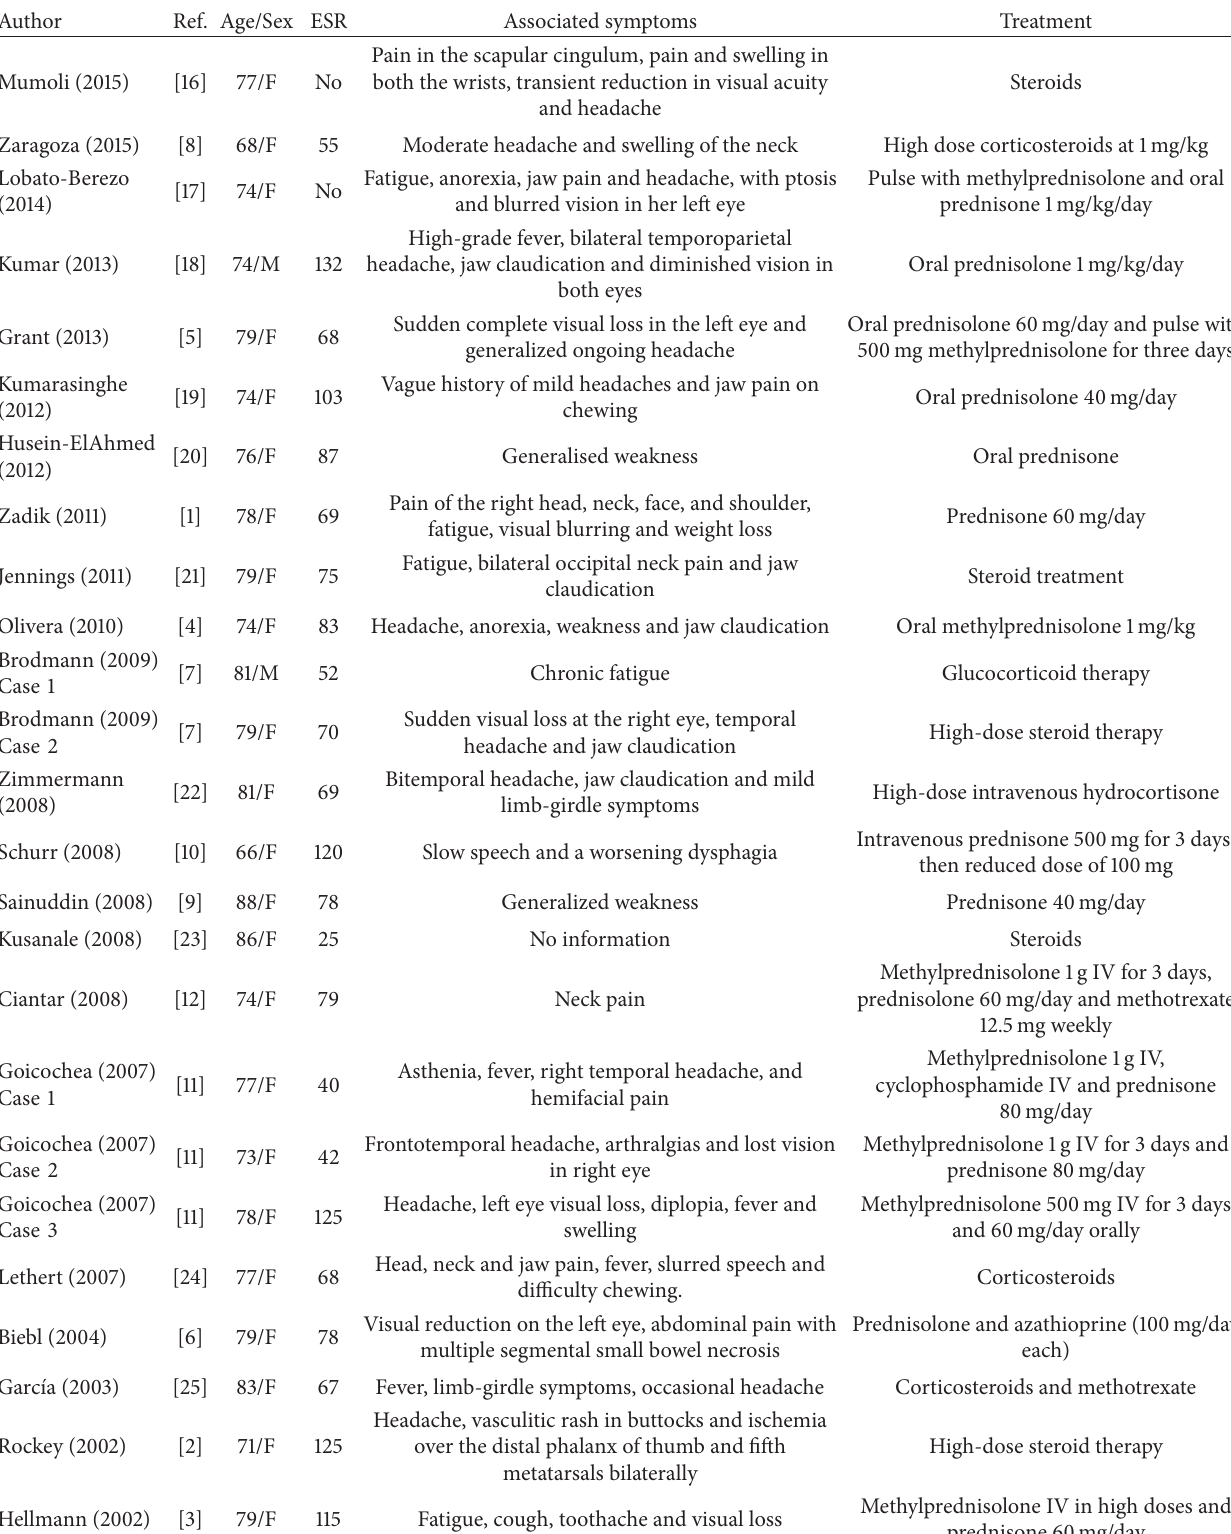
Table 1: Literature review of giant cell arteritis with tongue